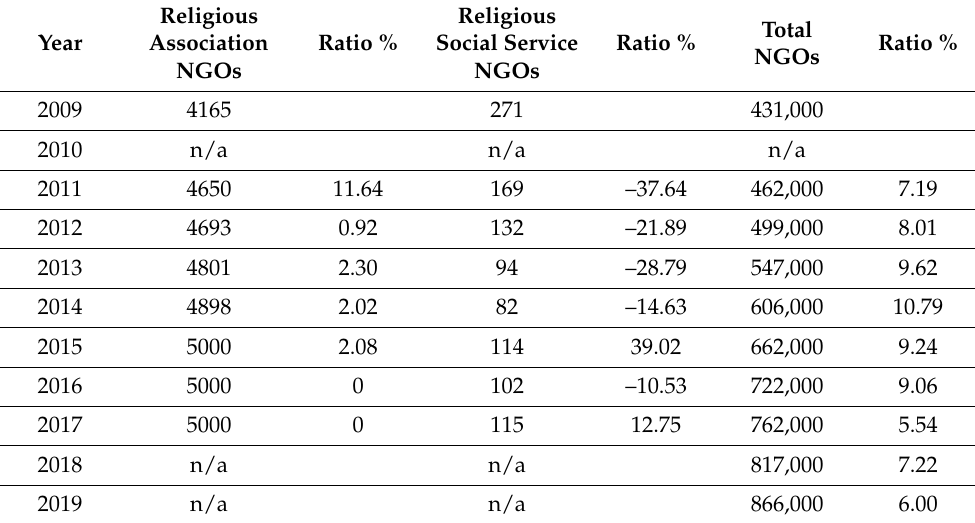
Table 1. Religious social organizations in China (2009–2019). Unit: